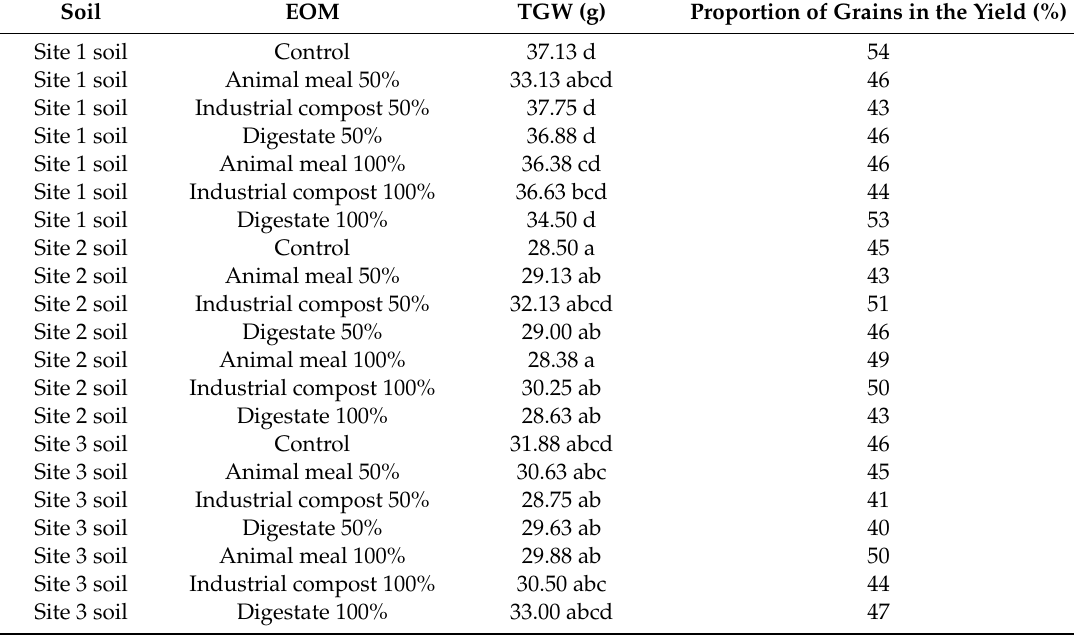
Table 6. Impact of fertilization regime on grain quality and contribution of grain to total above-ground plant